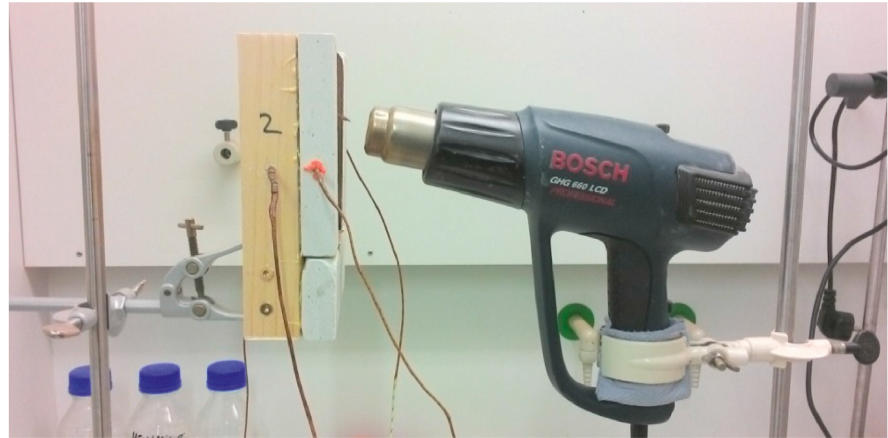
Figure 1: Setup of the hot-gun perforation test.